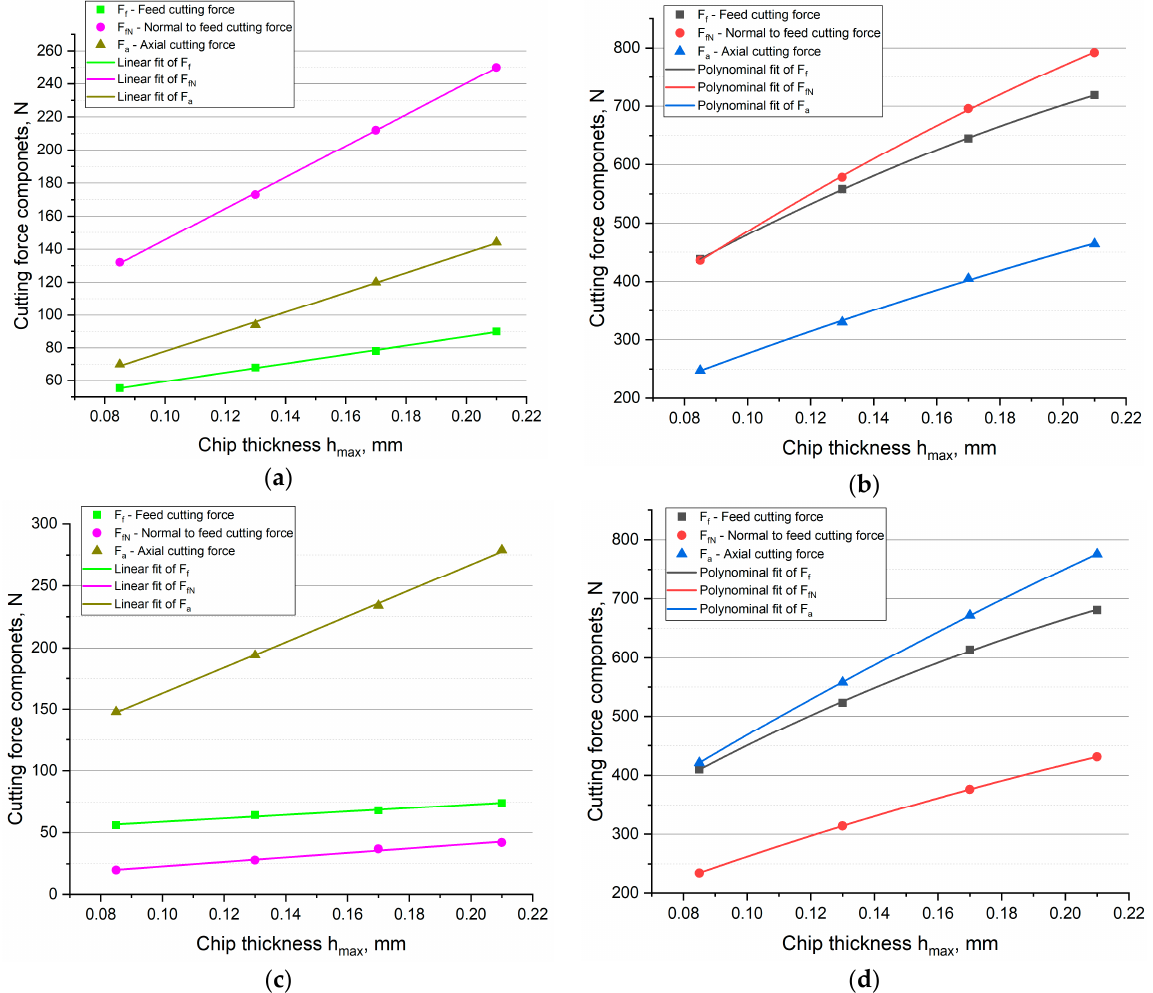
Figure 8. Curve fit for: ( a ) down milling with the conventional cutter, ( b ) down milling with the HF cutter, ( c ) up milling with the conventional cutter, (d) up milling with the HF cutter.